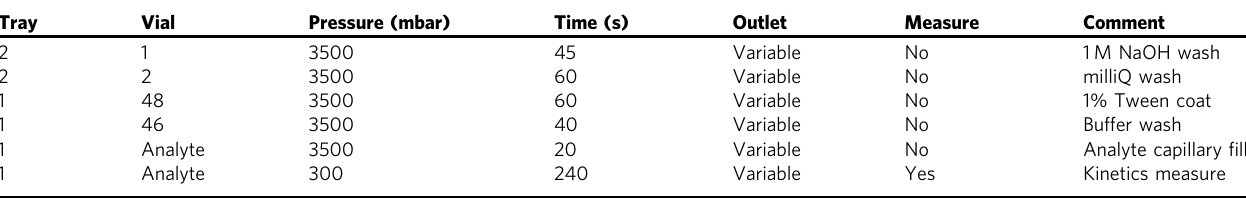
Table 7 Experimental parameters for Cap fl ex analysis of kinetics of droplet formation on the FIDA 1